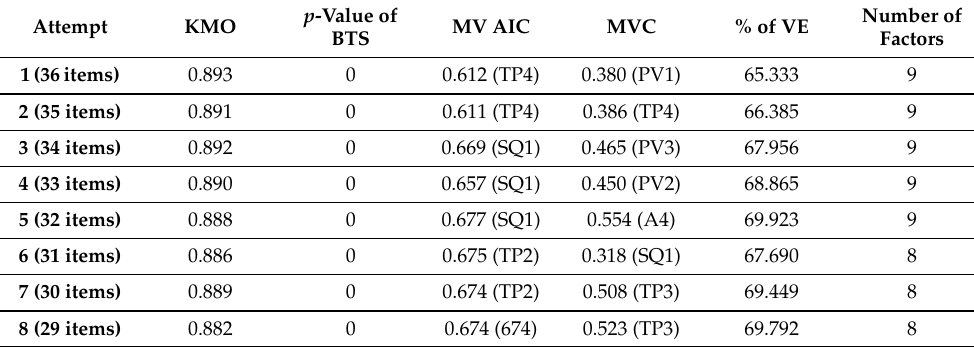
Figure 2. Scree plot: determination of factors. Table 3. Summary measures of different attempts. Note that MV AIC, MVC, and VE de- note minimum values of antiimage correlation, minimum value of commonalities, and variance extracted, respectively.